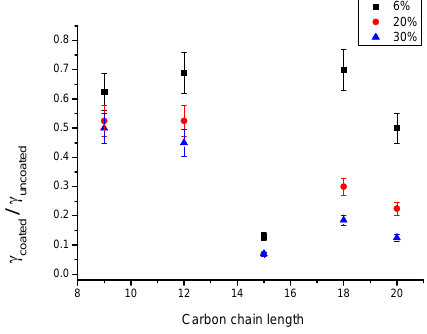
Fig. 6. Ratio γ coated /γ uncoated as a function of the carbon chain length for three different mass ratios of organic (black squares: 6%, red circles: 20%, blue triangles: